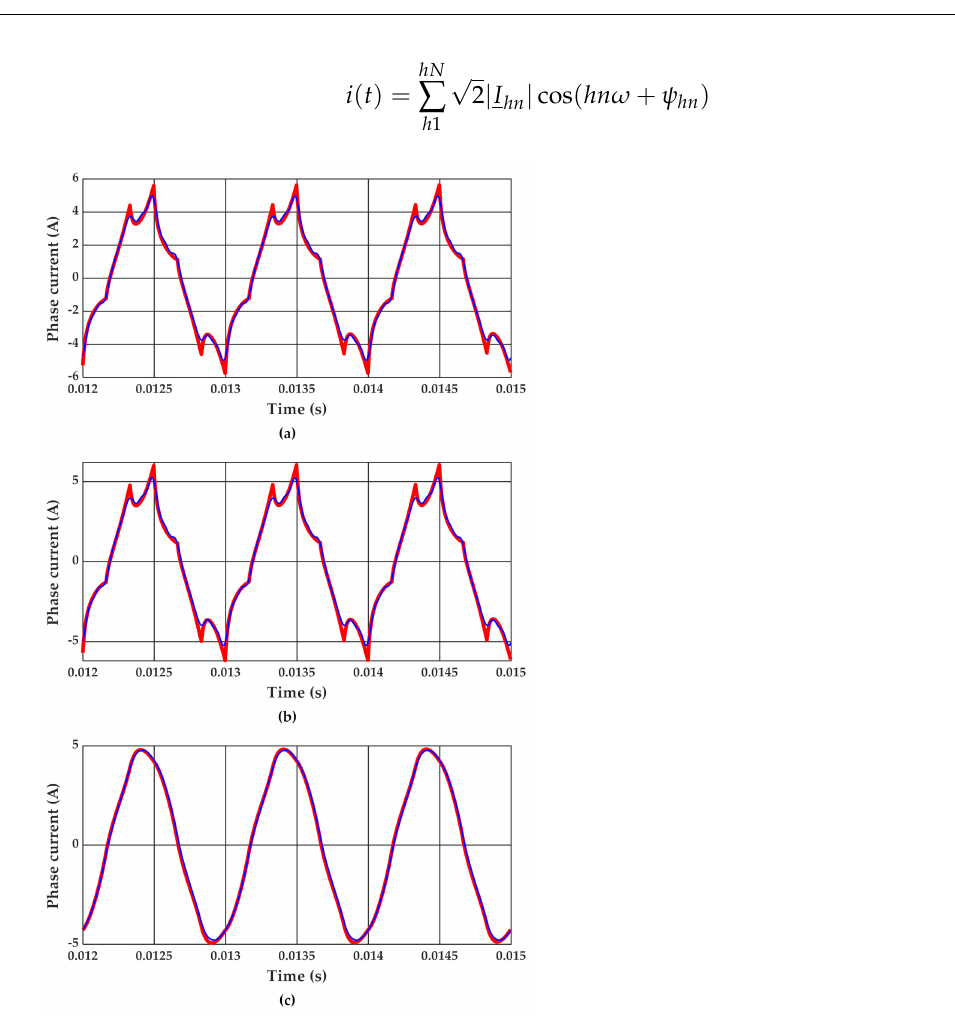
Figure 5. Comparison of the phase current waveforms calculated with the use of the time-domain model (red line) with the waveforms calculated with the use of the developed method (blue line) for a rotational speed of 24,000 rpm: square supply waveform ( a ), six-step supply waveform ( b ), trapezoidal supply waveform ( c